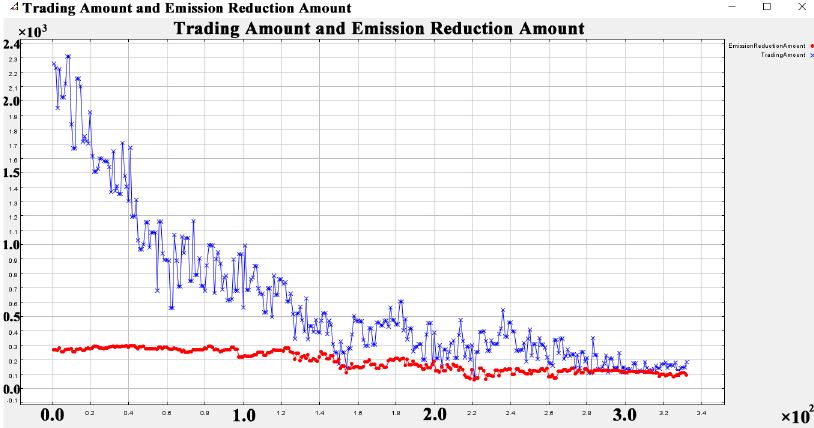
Figure 10. Quota purchase amount and emission reduction curve by step – public chain